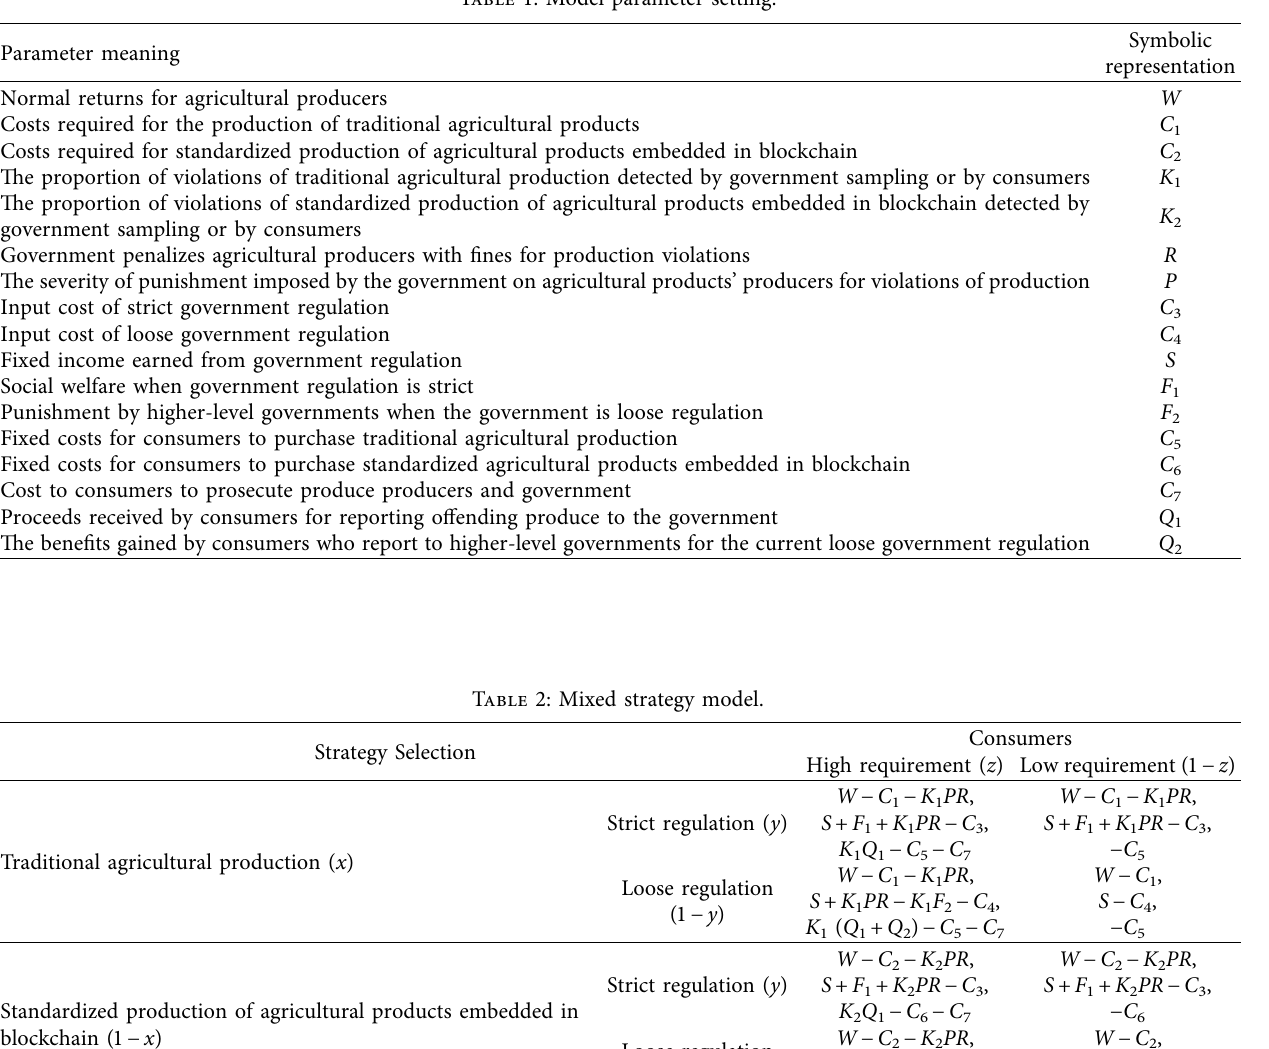
Table 1: Model parameter setting.